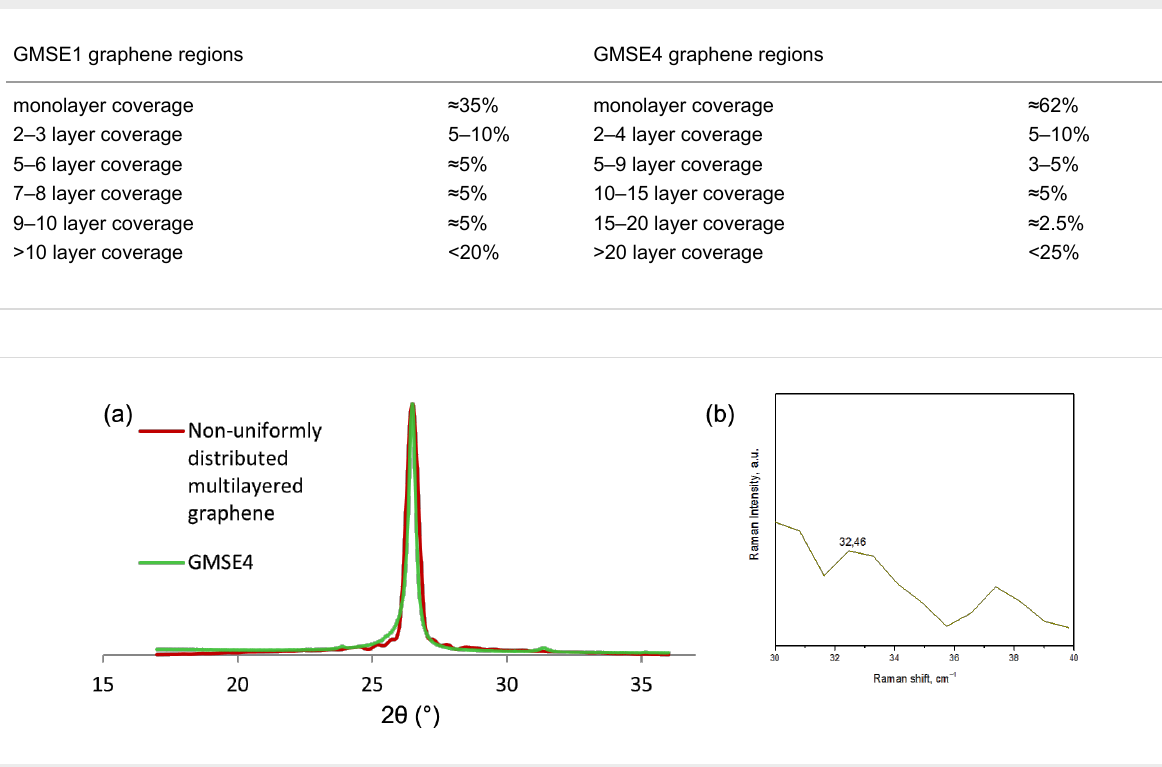
Table 1: Coverage of j -layer GMSE1 and GMSE4 graphene regions.